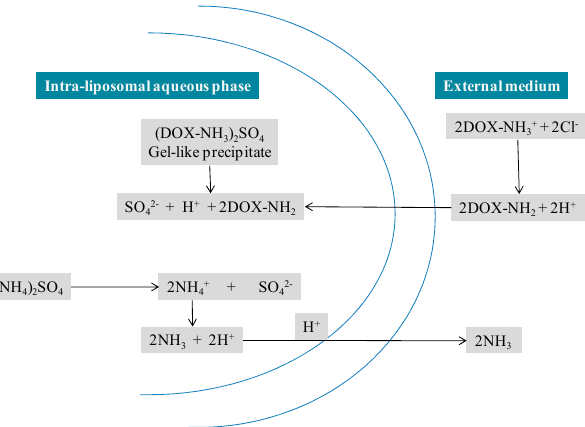
Figure 5. Remote loading approach of DOX into the intraliposomal aqueous phase. Liposomes are prepared at the desired concentration of ammonium sulphate. The gradient was formed by removing the ammonium sulphate from the external liposome medium. Intraliposomal NH 4+ dissociates into NH 3 and H + , NH 3 escape from the liposome and H + is retained in the liposome water phase. DOX HCl is added to the liposome dispersion at a temperature above the phase transition of the liposomal lipids. DOX, a cationic amphiphile, is present in equilibrium between an ionised and a non-ionised form. The latter form commutes across the liposome bilayer and becomes ionised once exposed to the internal H + environment, and forms a salt with the SO 42 − anions.